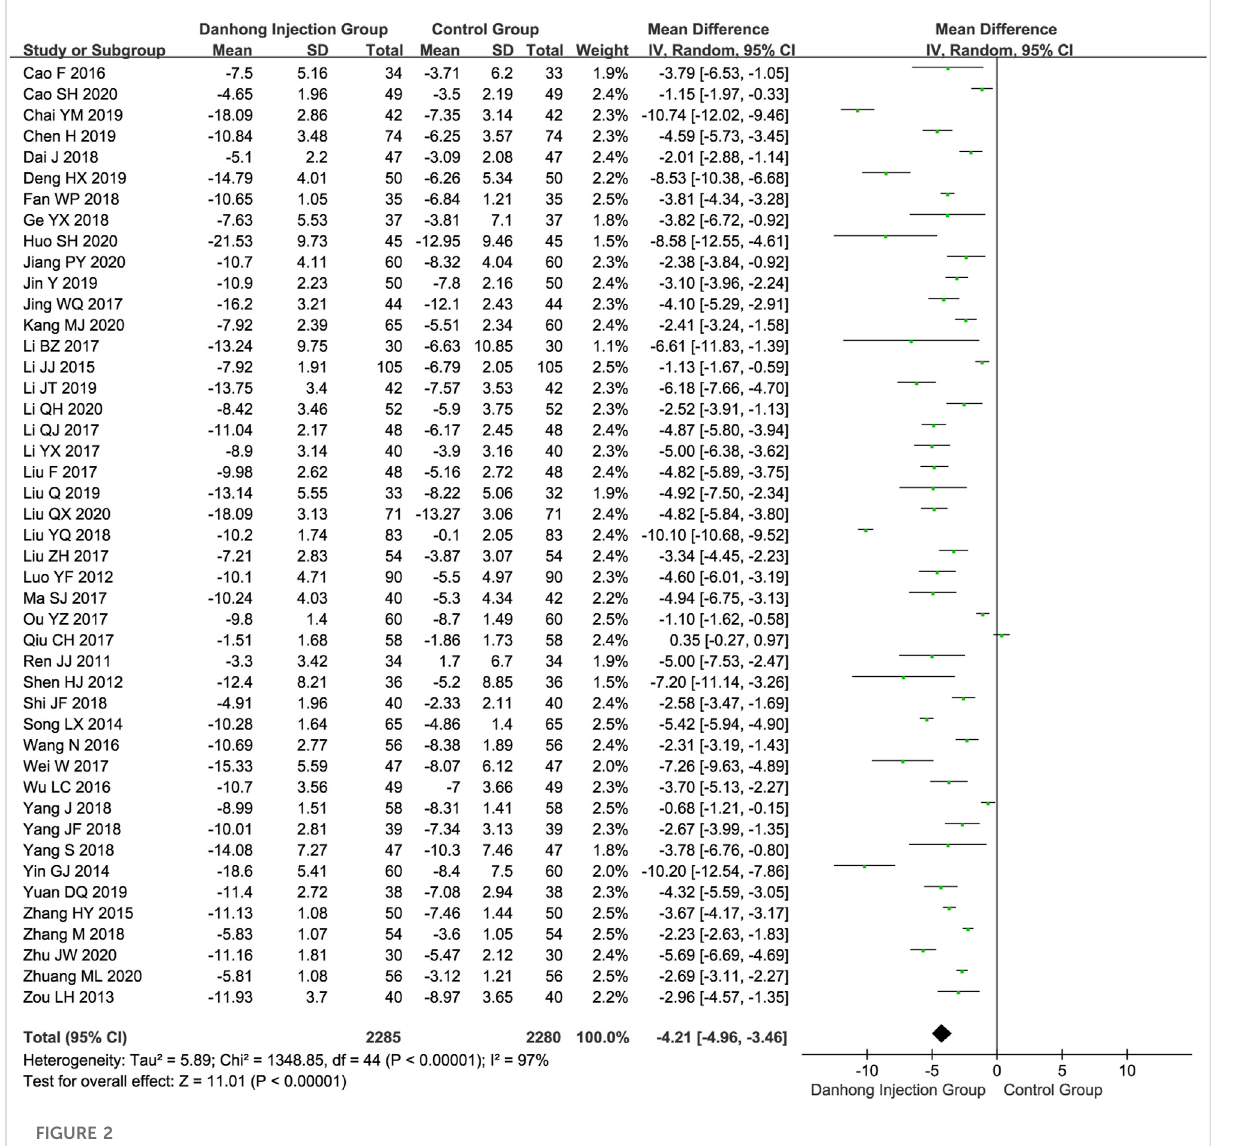
FIGURE 2 Meta-analysis of NIHSS between DHI + WM and WM in patients with ischemic stroke.